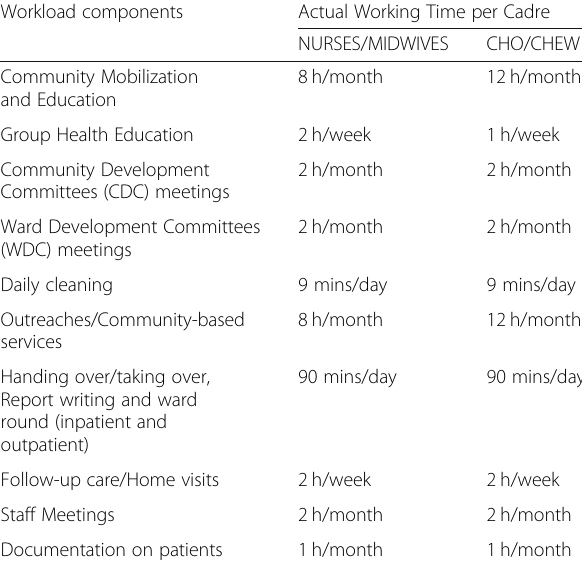
Table 3 Validated support activities and category allowance